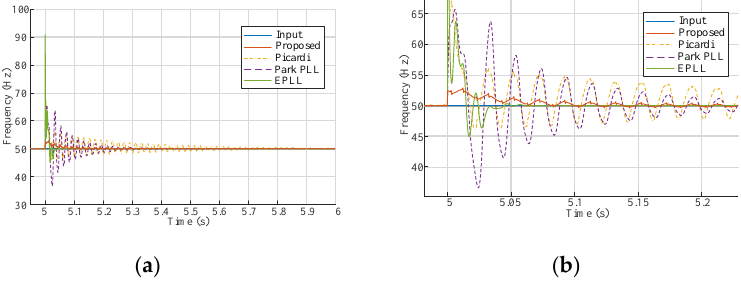
Figure 16. Comparison of frequency detection techniques for a 40° phase jump for a 1 pu ( a ) 50 Hz; ( b ) zoomed for 50 Hz. Electronics 2020 , 9 , x FOR PEER REVIEW